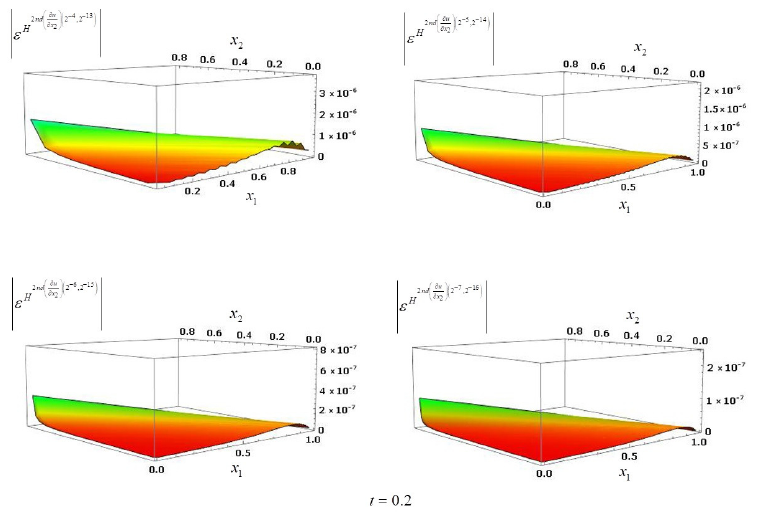
(cid:16) (cid:17) ∂ u . ∂ x 2